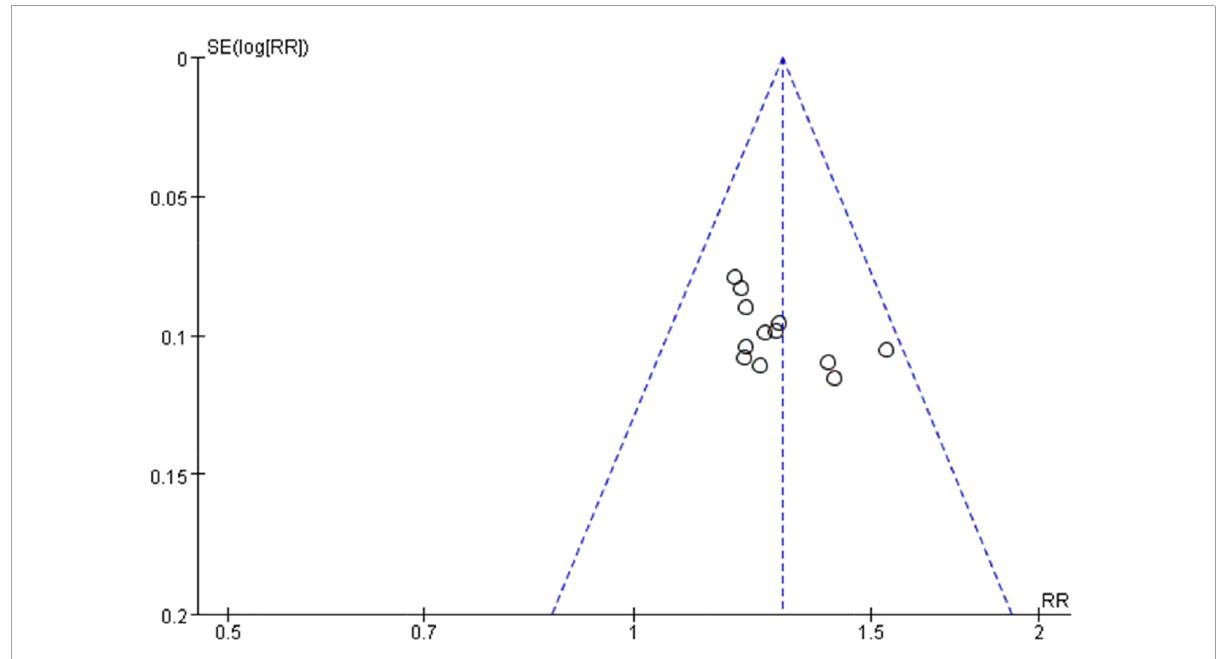
FIGURE8 Funnel plot of the clinical effectiveness reported by 12 included studies using the accepted standard (i.e., “Effective”: clinical symptoms alleviated and the frequency of premature contraction in electrocardiogram was reduced by 50% or more. “Not effective”: failed to meet the above